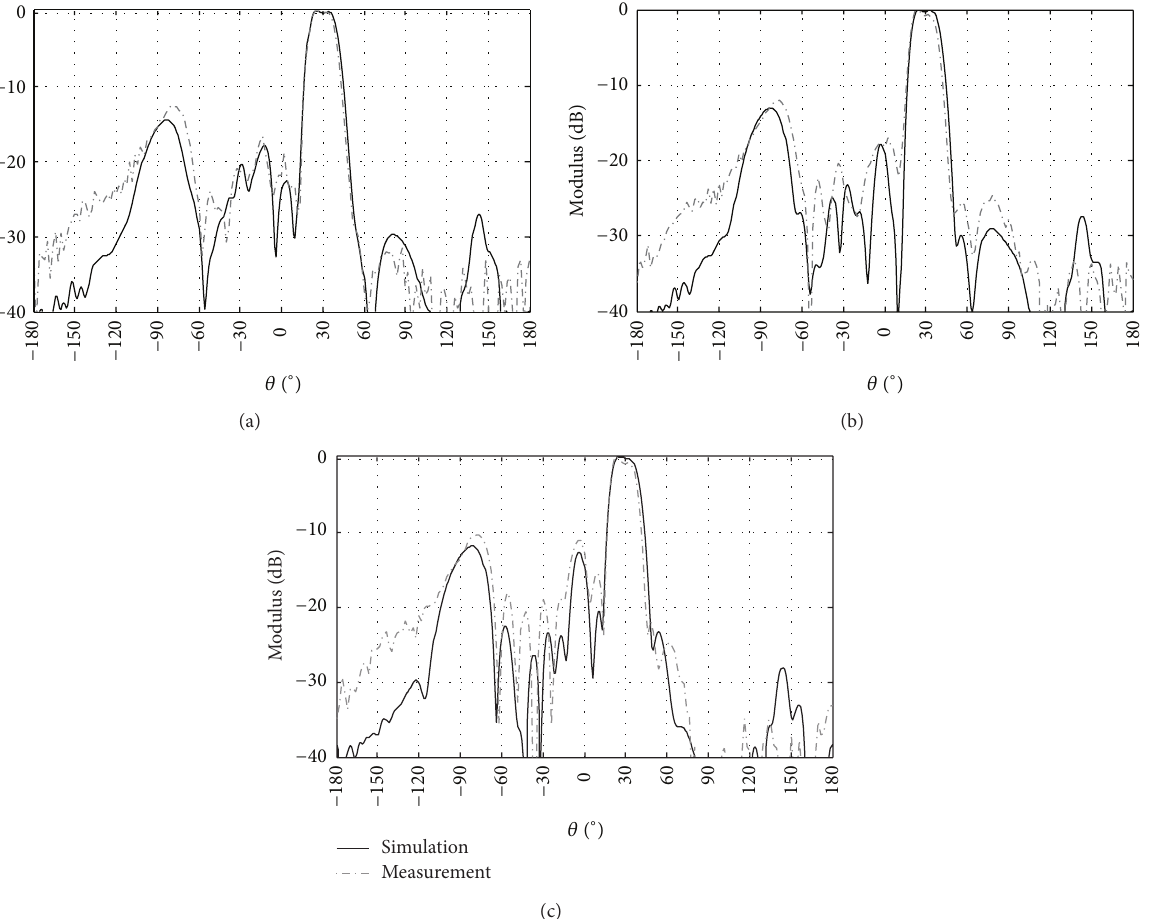
Figure 15: Comparison between simulated and measured normalized sectorial radiation patterns at 30 ∘ pointing angle direction: (a) 8 GHz, (b) 8.2 GHz, and (c) 8.4